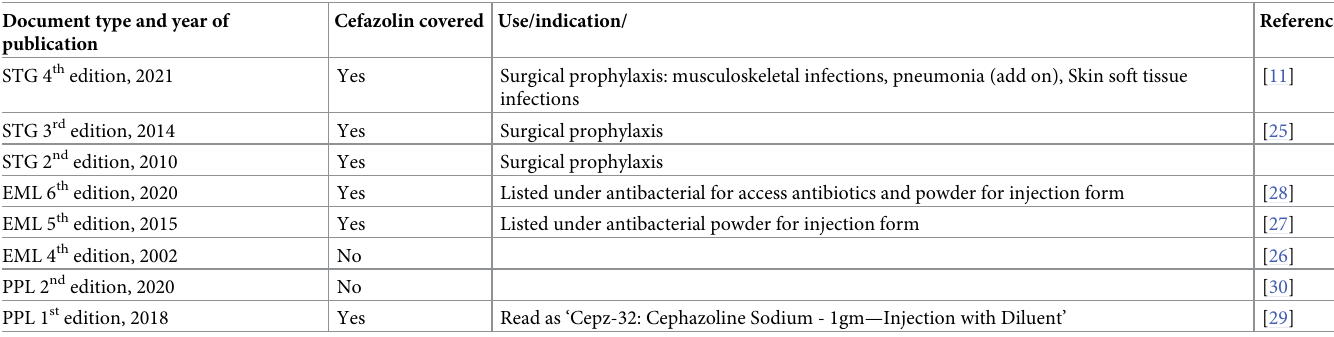
Table 1. Cefazolin inclusion in the national guidelines and medicine lists, July to August 2021. Document type and year of